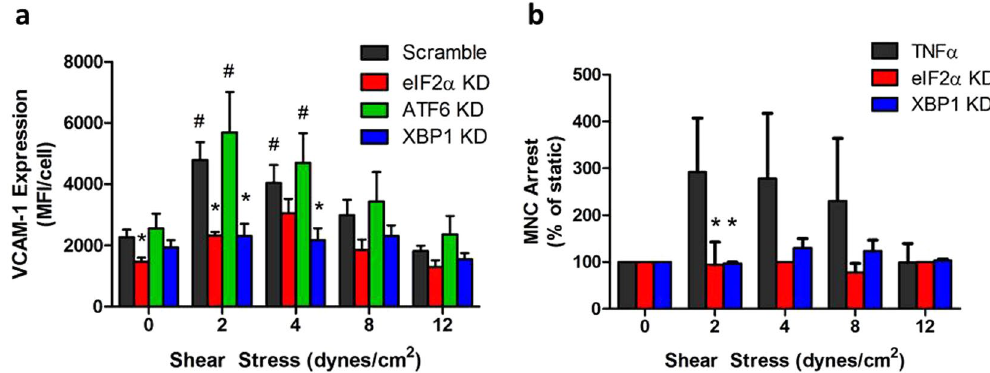
Figure 4. XBP1 and eIF2 α activation are necessary for SS regulation of VCAM-1. ( a ) HAEC were transfected with shRNA against eIF2 α , ATF6, XBP1, or a scrambled control. Monolayers were treated with SS and TNF α for 4 hrs then analyzed for VCAM-1 protein expression via immunofluorescence microscopy. ( b ) MNC arrest was quantified in HAEC lacking XBP1 or eIF2 α . Values are mean ± SE, n = 4–5, # P < 0.05 vs static within group. * P < 0.05 vs scrambled control at respective SS.